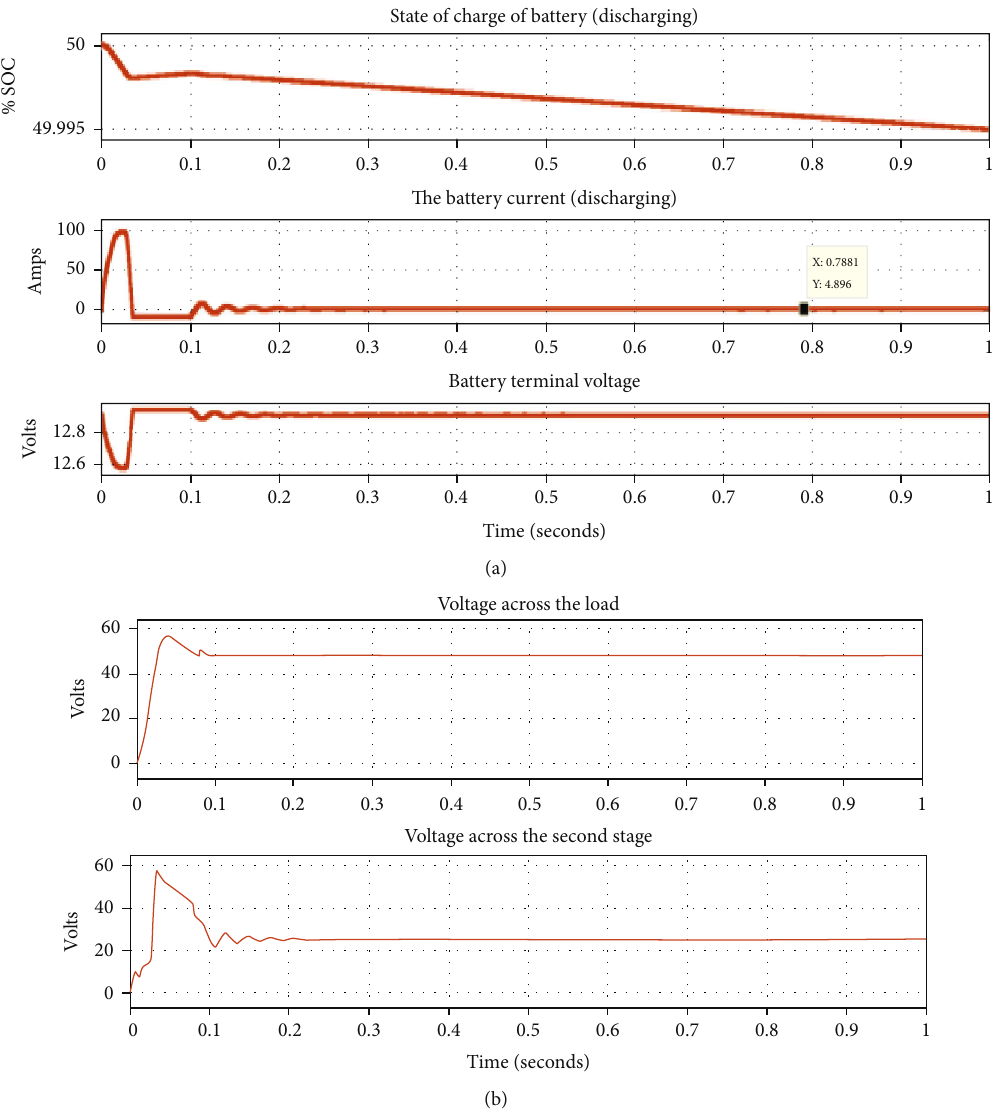
Figure 16: (a) Battery SOC, current, and terminal voltage. (b) Output of generic boost and fi nal V